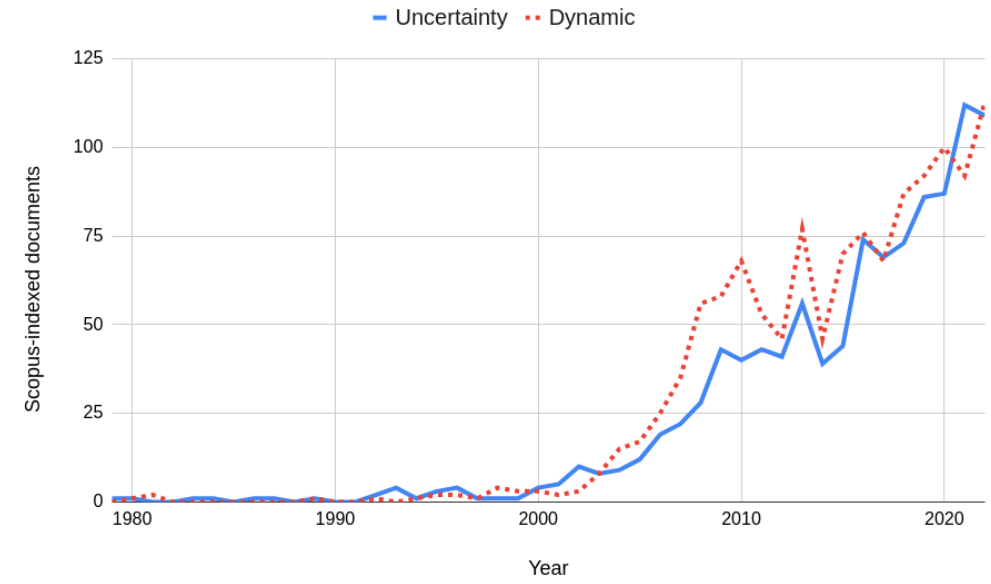
Figure 1. Evolution of Scopus-indexed papers on VRPs with uncertainty or dynamic